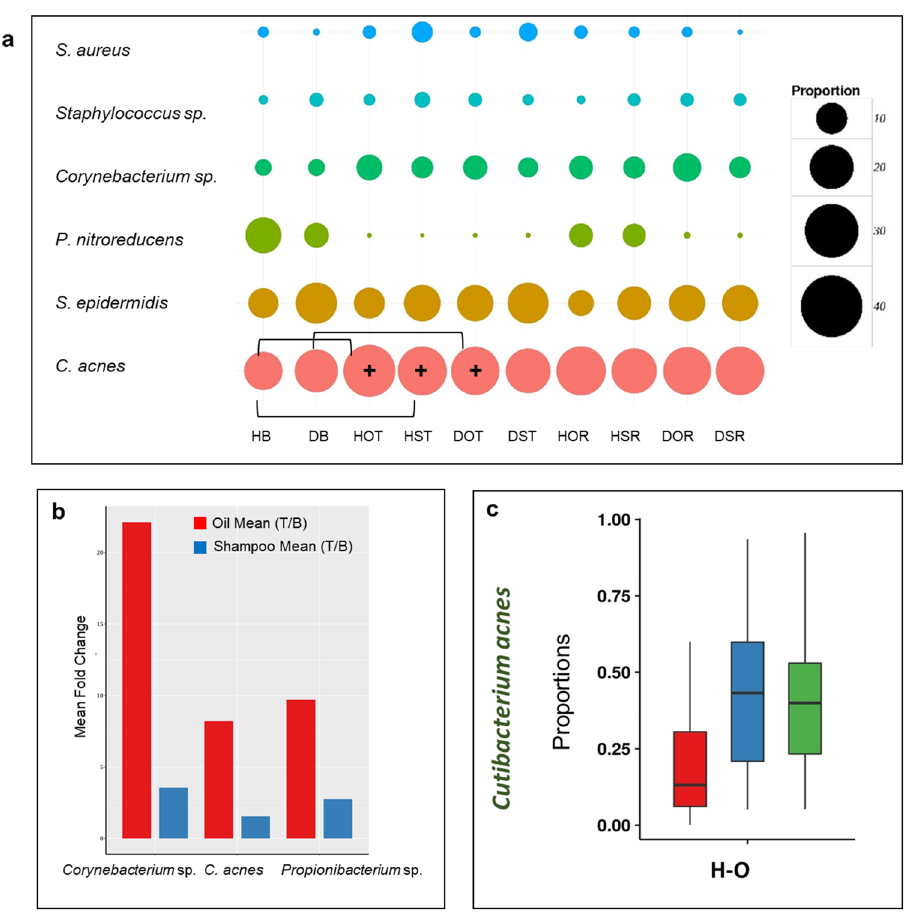
Figure 3. Comparison of bacterial population at the three phases. ( a ) Bubble plots representing the top five bacterial species across all the groups. The bubble size indicates mean relative abundance of species within each group. Square brackets indicate the groups between which a significant difference in the species abundance was observed ( p ≤ 0.05, Wilcoxon test, + indicates the group with the higher abundance among the two). ( b ) Significant fold-change differences ( p ≤ 0.05) observed in bacterial species abundance between oil-treatment and shampoo-application. No significant difference was observed in the fungal species between the two treatment groups. ( c ) Core bacterial species showing significant variations across the three phases (FDR adjusted p ≤ 0.05, repeated measures